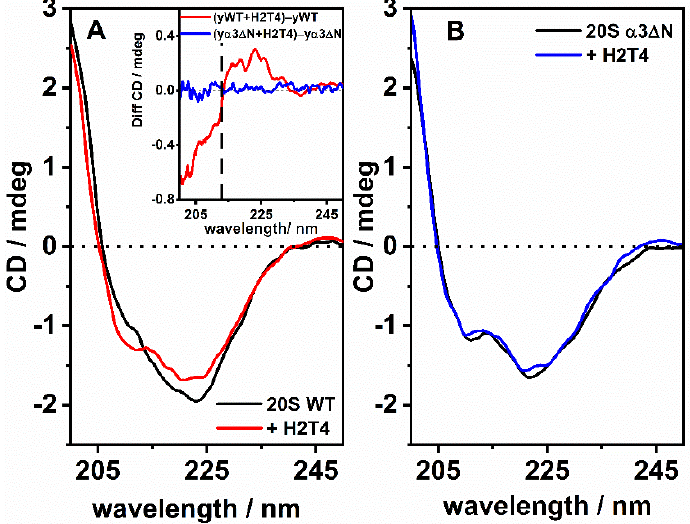
Figure 4. ECD spectra of y20S (panel A ) and y α 3 ∆ N (panel B ) 20S proteasomes 25 nM, in 150 mM Tris buffer with 100 mM of NaCl at pH 7.6, before (black trace) and after addition of H2T4 10 µ M (red and blue traces for WT and y α 3 ∆ N, respectively). Inset: comparison of ECD differences between the spectra of y α 3 ∆ N in the presence of H2T4 and that of y α 3 ∆ N (blue traces) and yWT in the presence of H2T4 and that of yWT.